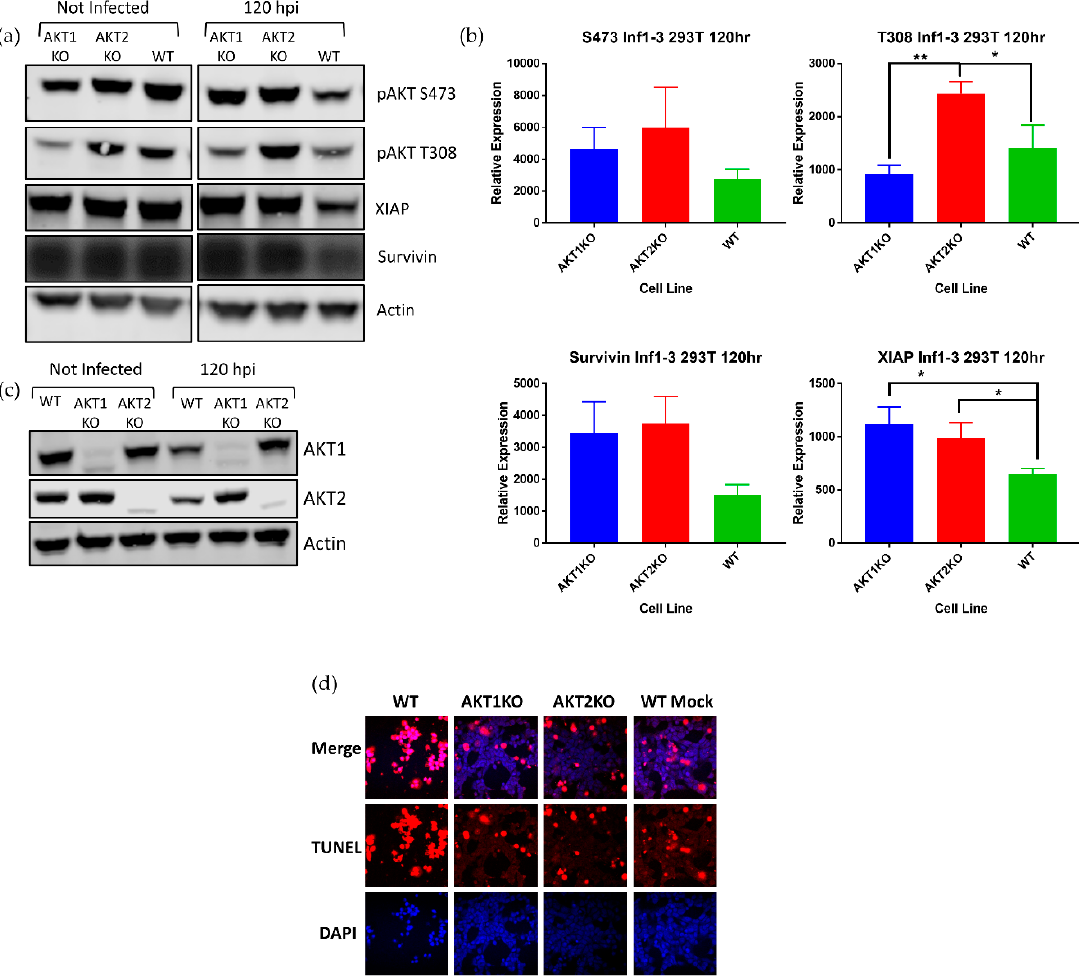
Figure 4. Higher pAKT levels in AKT KO cell lines show resistance to LGTV-induced apoptosis. AKT1 KO, AKT2 KO, and WT 293T cells were infected with LGTV at an MOI of 0.1. ( a ) Comparison of pAKT, XIAP, and survivin levels in wild-type and AKT knock out cells at 120 hpi. ( b ) Densitometry measurements of the blots in A show that there is significantly more XIAP present in AKT1 KO and AKT2 KO cells than WT cells at 120 hpi, * p < 0.05, ** p < 0.01 (one-way ANOVA followed by Tukey’s multiple comparison test). Error bars indicate standard deviation from three independent experiments. ( c ) In addition to higher levels of pAKT, AKT1 KO and AKT2 KO cells have more AKT1 or AKT2. ( d ) TUNEL staining (red) at 168 hpi shows substantially more apoptosis in WT cells than AKT1 KO and AKT2 KO cells. Nuclei were counterstained with DAPI (4 ′ ,6-diamidino-2- phenylindole; blue). Images were taken with a 40× objective.